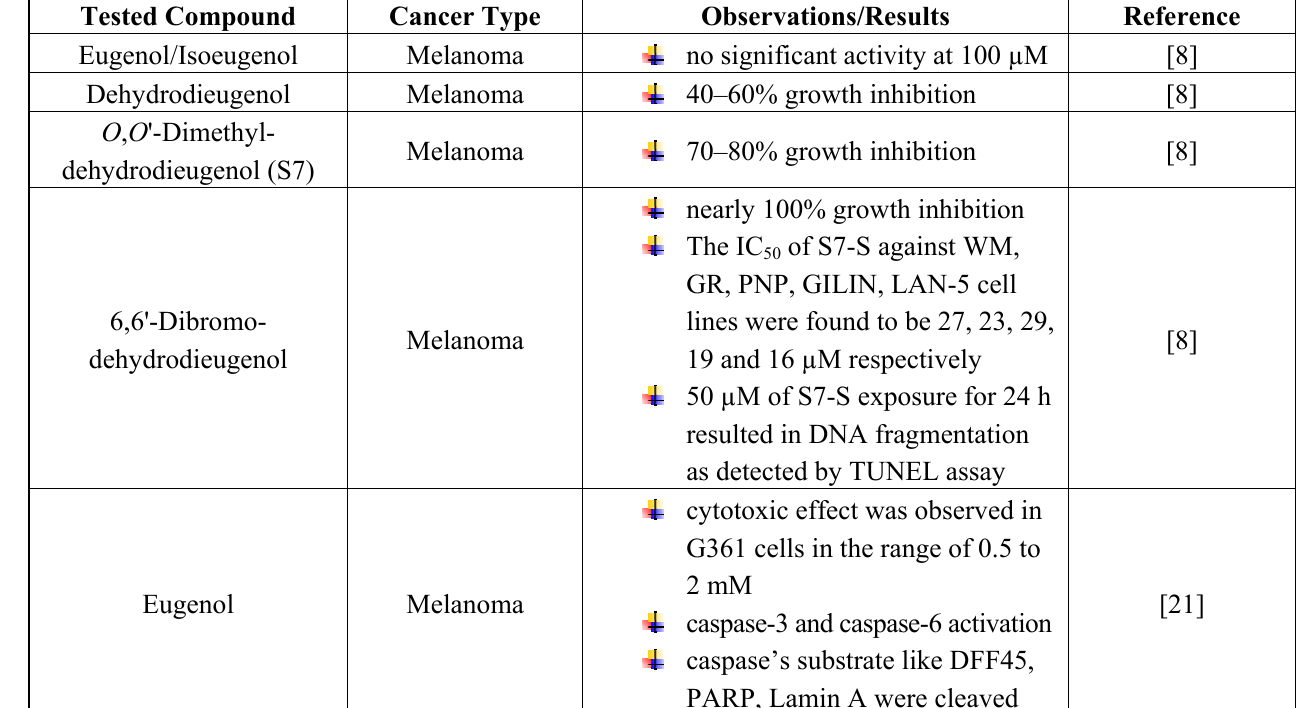
Table 1. Antiproliferative and molecular mechanism of eugenol-induced apoptosis. Tested